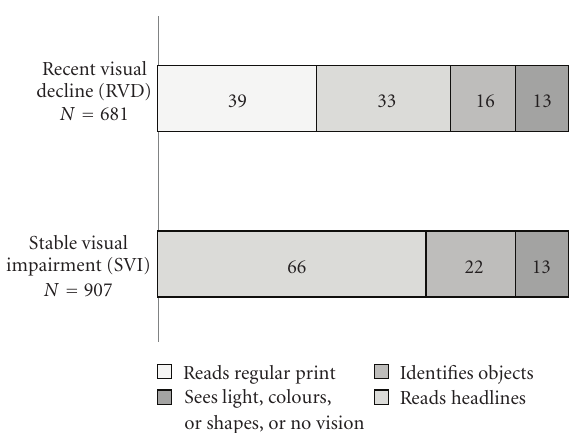
Figure 3: Visual ability in two groups of older homecare clients: stable visual impairment and recent visual decline (for the period of the last 90 days) (%); N =